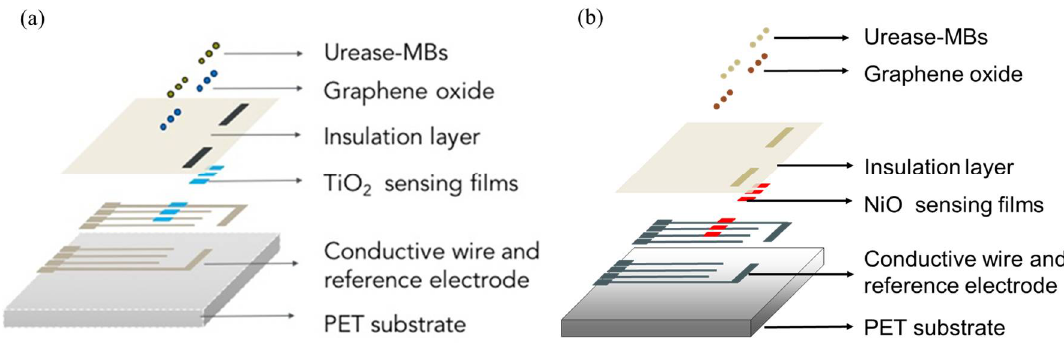
Figure 2. The structure schematics of (a) the MBs-urease / GO / TiO2-based biosensor [25] and (b) the MBs-urease / GO / NiO-based biosensor [26].